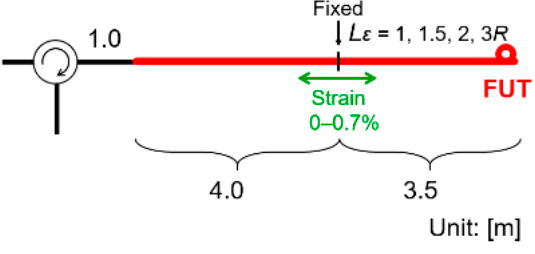
Figure 2. Structure of fiber under test